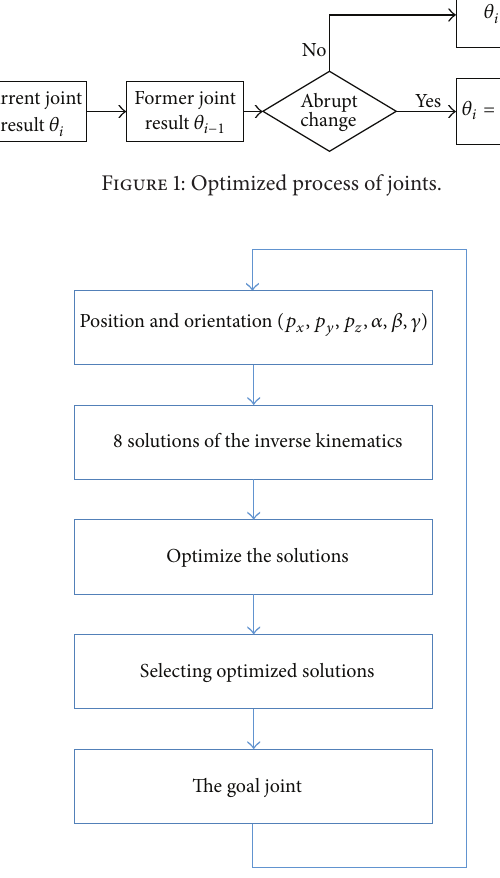
Figure 2: Optimization of the inverse kinematics solution.